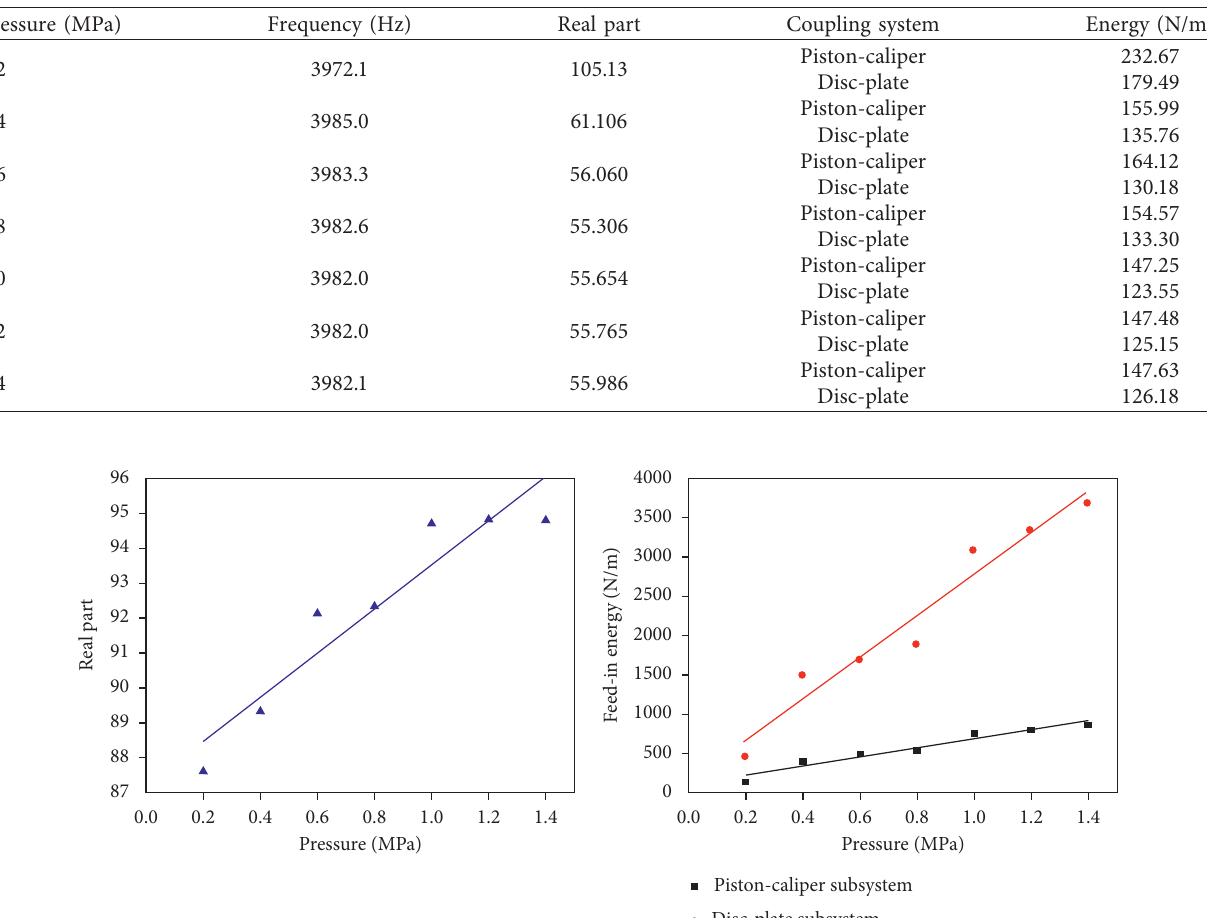
Table 5: Feed-in energy of the dual coupling subsystem near 4000Hz.